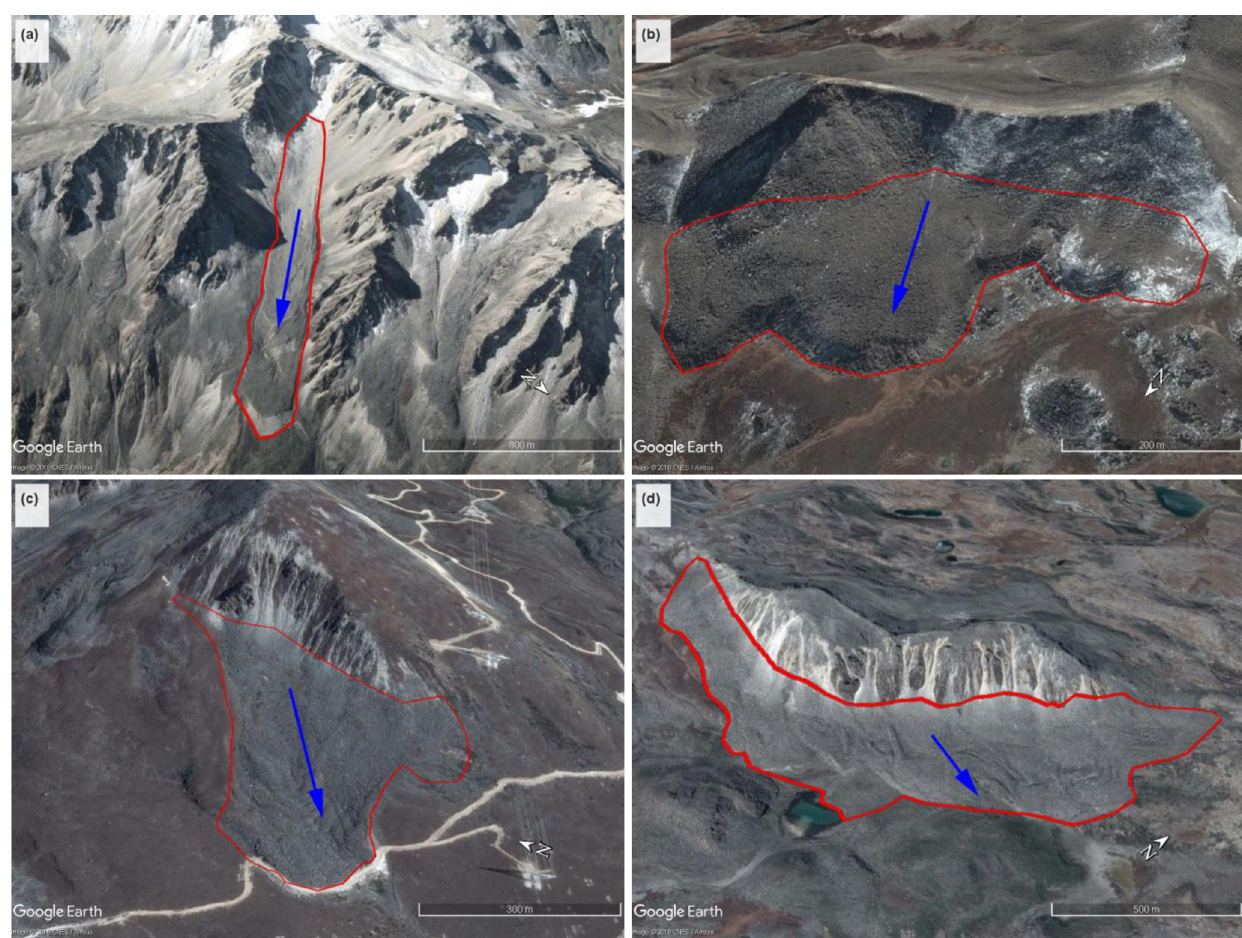
Figure 2. Example images of different types of rock glaciers in Daxue Shan: (a) moraine-type and tongue-shaped rock glaciers (30.332767 ◦ N, 101.707756 ◦ E) (30 January 2017), (b) moraine-type and lobate rock glaciers (30.217147 ◦ N, 101.791585 ◦ E) (15 Novem- ber 2015), (c) talus-derived and tongue-shaped rock glaciers (30.067066 ◦ N, 101.819432 ◦ E) (21 October 2014), and (d) talus-derived and lobate rock glaciers (30.127825 ◦ N, 101.812158 ◦ E) (21 October 2014). The red lines show the outlines of the rock glaciers; the blue arrows indicate the direction of flow of the rock glaciers. Map data: Google,